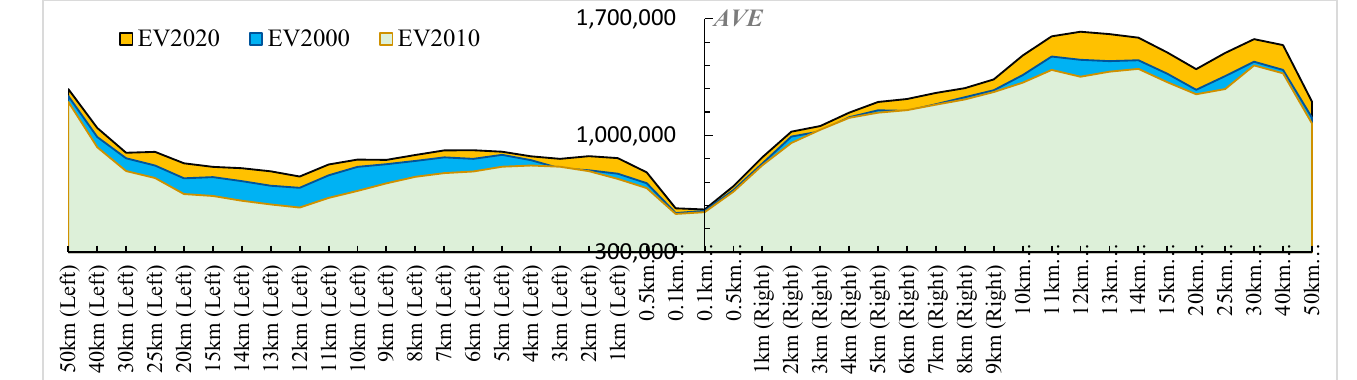
( e ) Figure 5. LF of different road sections and different buffers. ( a ) LF in 2000; ( b ) LF in 2010; ( c ) LF in 2020; ( d ) increase in LF from 2000 to 2010; ( e ) increase in LF from 2010 to 2020. 3.2. Ecological Service Value in Different Units Figure 6 displays the average ecological service value ( AEV ) for different buffers along the QTR, indicating that, to a certain extent, there was a positive association between the AEV and the buffer width, although the difference between the two sides of the rail- way was very obvious. For most study units, there was a clear change in the AEV findings over time, which declined from 2000 to 2010 and increased from 2010 to 2020. However, the relative dispar- ities between the different buffers were generally consistent. The AEV was obviously the lowest for the 0.1 km buffers. When the buffer width exceeded 0.5 km, the AEV results then had an upward trend. However, the buffers on the left and right sides differed significantly from one an-